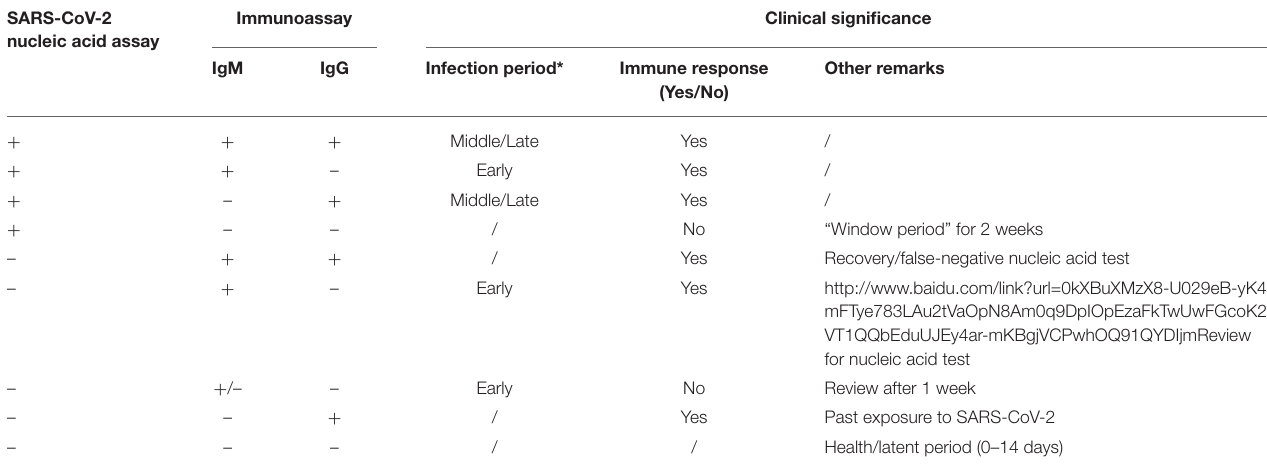
TABLE 4 | Clinical significance of SARS-CoV-2 detection in COVID-19 patients. SARS-CoV-2 nucleic acid